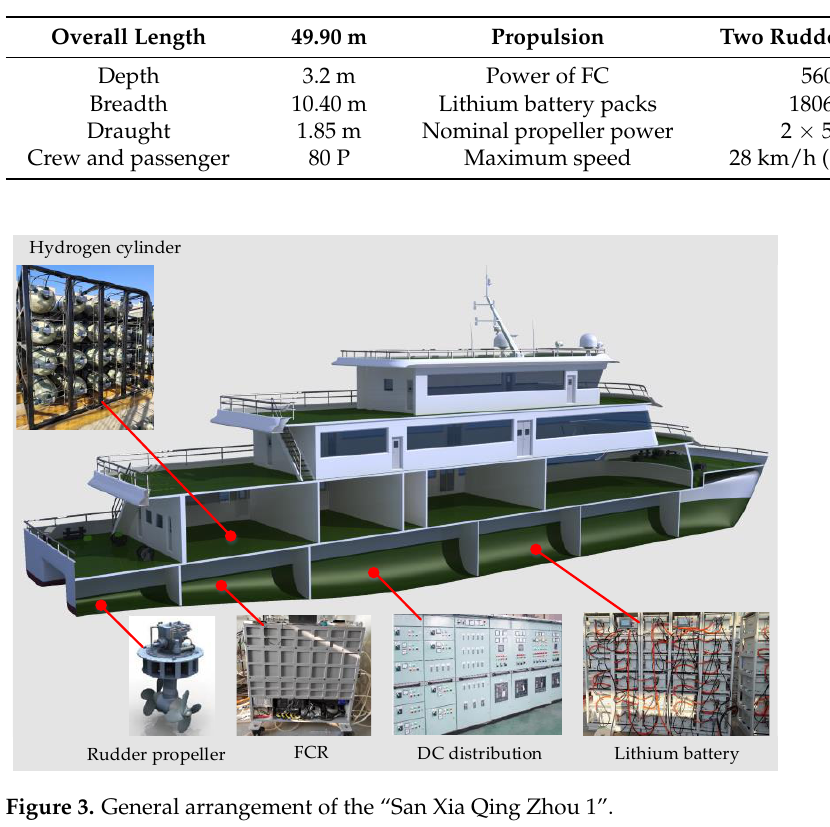
Figure 3. General arrangement of the “San Xia Qing Zhou 1”.